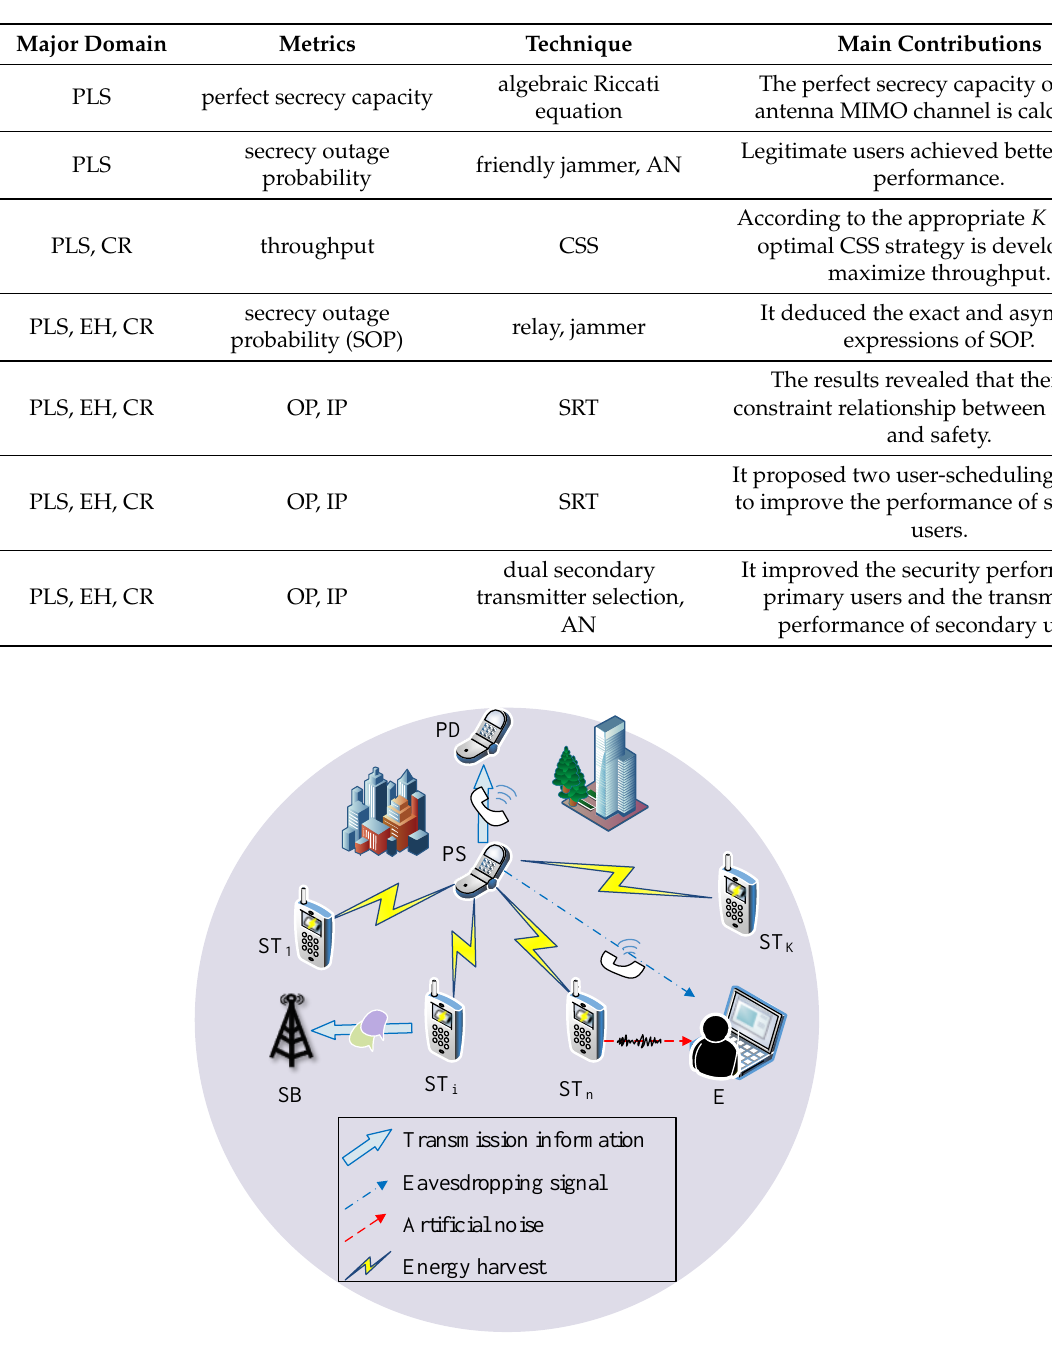
Figure 1. System